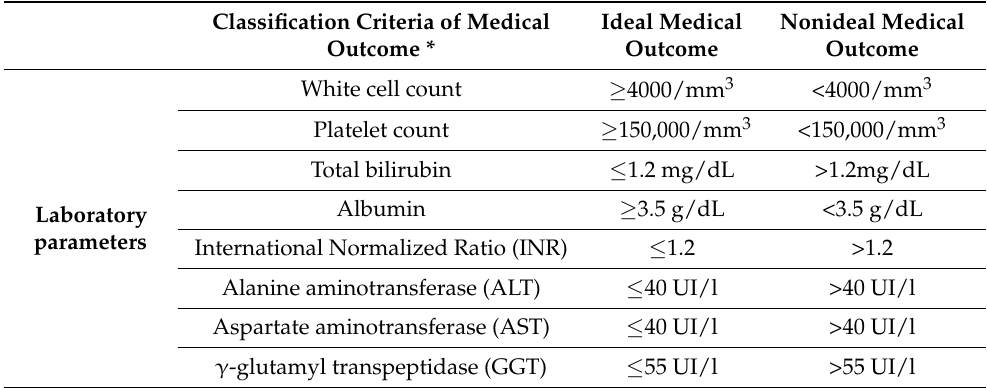
Table 1. Laboratory and clinical criteria of medical